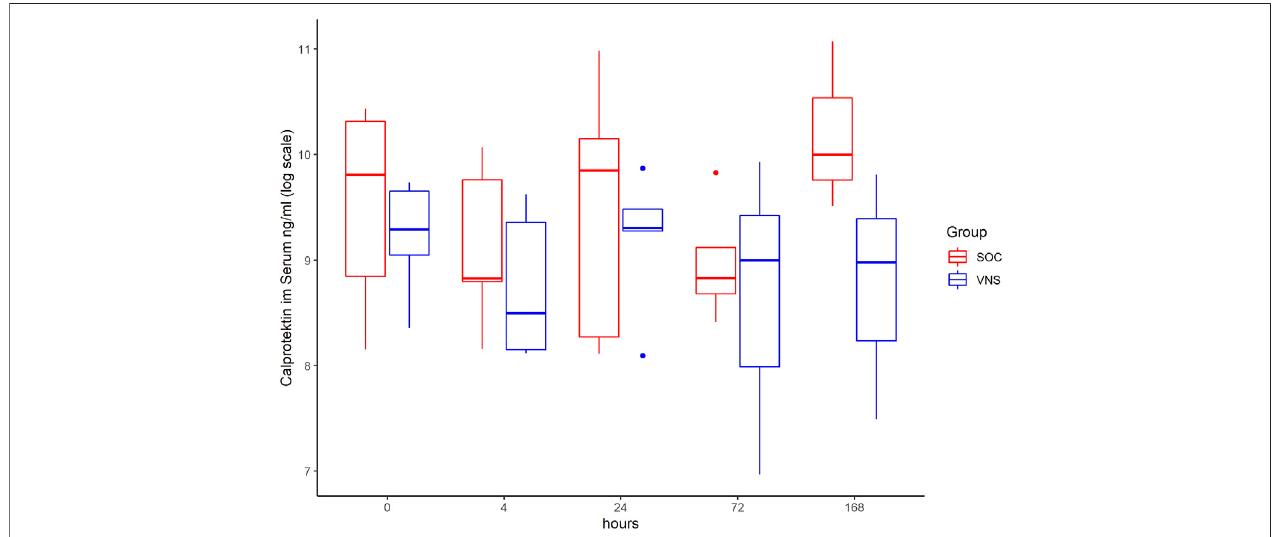
FIGURE5| MedianCalprotektinlevelwithInterquartileRangeofpatientsreceivingauricularVagusStimulation(VNS=blue)andpatientsonlyreceivingStandardof Care (SOC = red) after 0, 4, 24, 72, and 168 h of study inclusion.